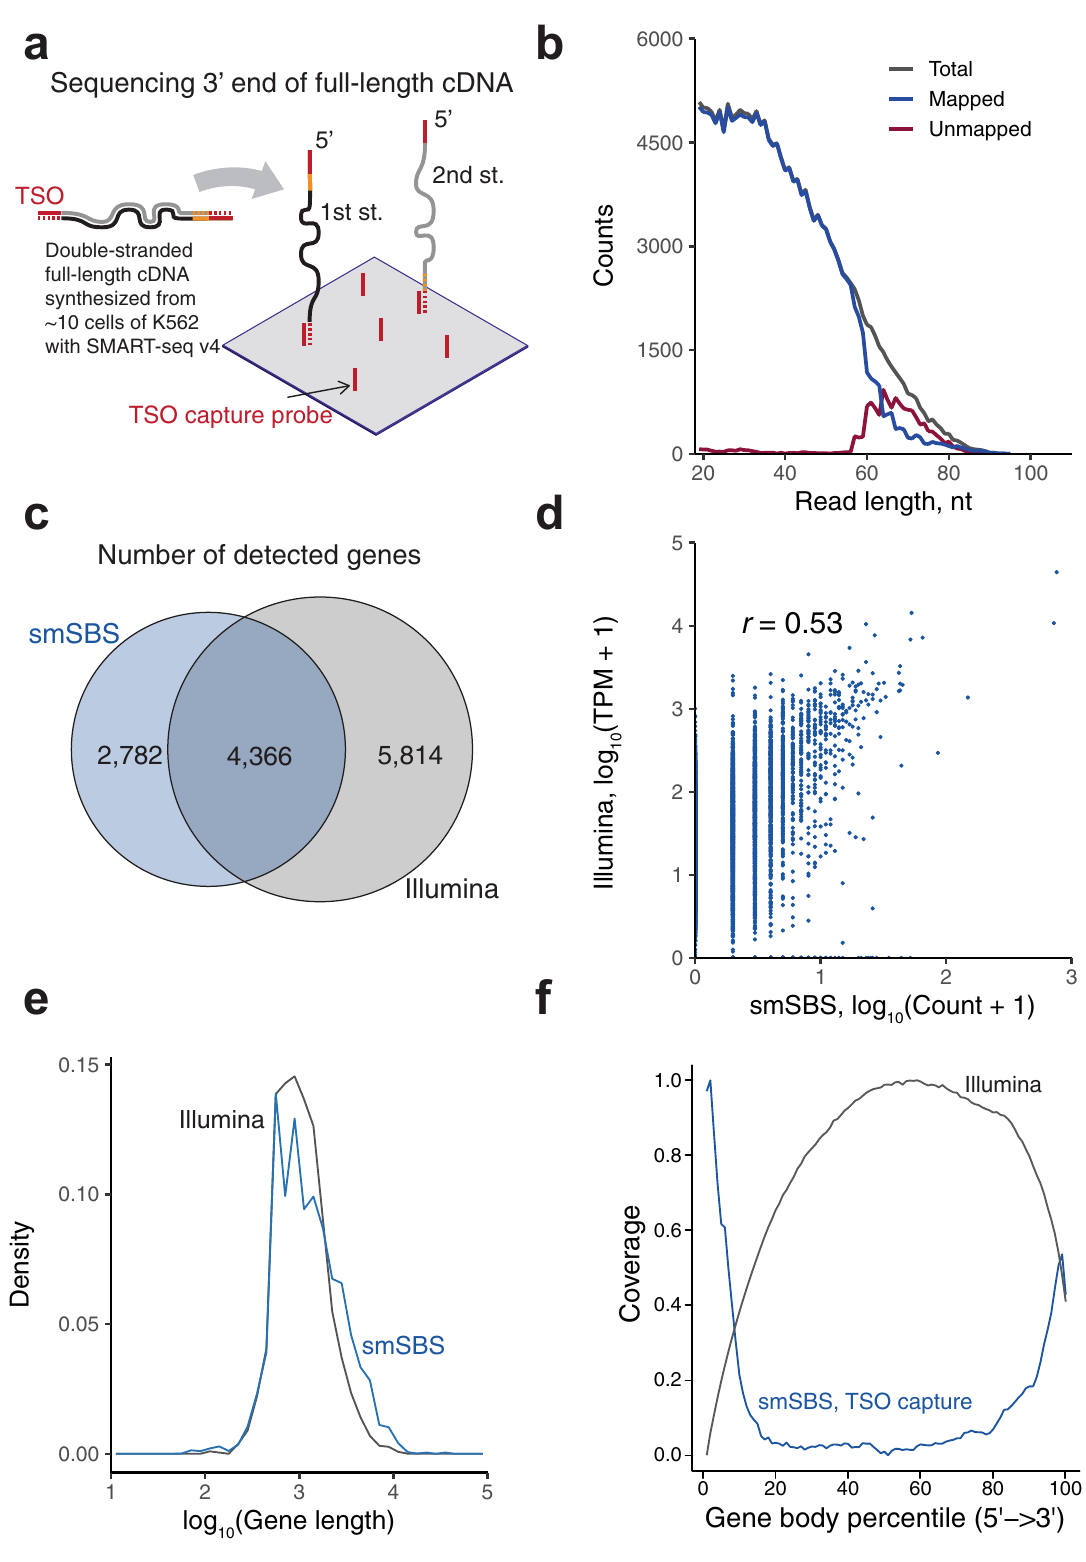
Fig. 2 Application of smSBS to a small quantity (~10 pg) of cDNA library of K562 cells. a Schematic illustration for the capture and sequence of unfragmented full-length cDNAs. Lines in the cDNA molecules indicate TSO (red solid), complementary of TSO (red dashed), polydT (yellow solid), and poly-A (yellow dashed). b Read length distribution after 24Q sequencing; reads <19 nt and containing byproducts were fi ltered out. c Venn diagram of the number of genes detected with smSBS and an Illumina sequencer (Hiseq2500). Genes detected with smSBS and Illumina were counted as HTseq-count > 0 and TPM of RSEM > 0, respectively. d Comparison of gene expressions obtained via smSBS and Illumina. e Normalized density plot of gene length detected via smSBS and Illumina. f Gene body coverage via smSBS and Illumina. Note that, the Illumina results shown in c – f were calculated with the reads down-sampled into 200k paired-end